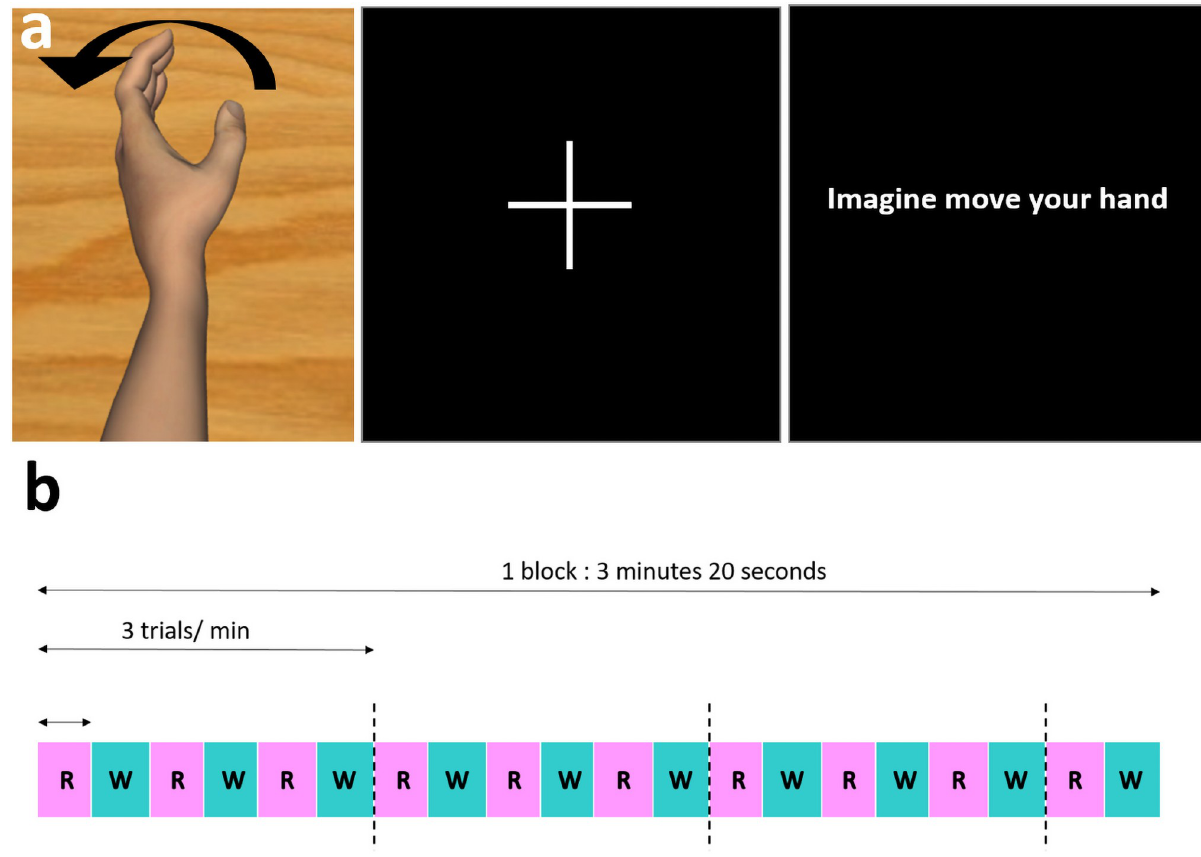
Fig 2. Description of the recorded sessions. a) Visualization of the condition on the screen: a virtual moving hand during vibration (combined condition and VPI condition), or a cross on the screen for a resting period, or a visual instruction on the screen to perform motor imagery tasks (MI condition). b) Descriptive diagram of one round. "R » means resting period and "W" means indifferently visuo-proprioceptive stimulation, Motor Imagery or combined stimulation.